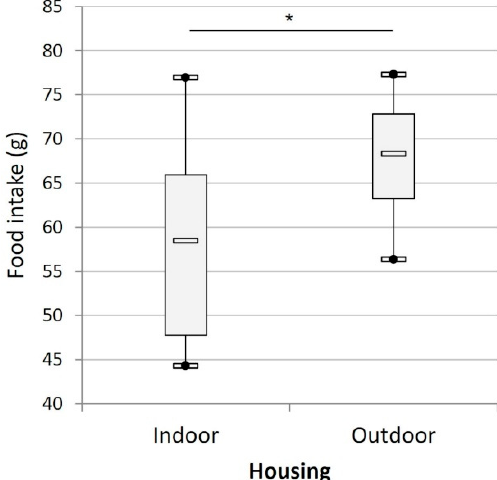
Figure 9. Mean daily food consumption (g) of the cats according to their housing condition (indoors (n = 15) versus outdoors (n = 8)). (*) indicates p < 0.05.